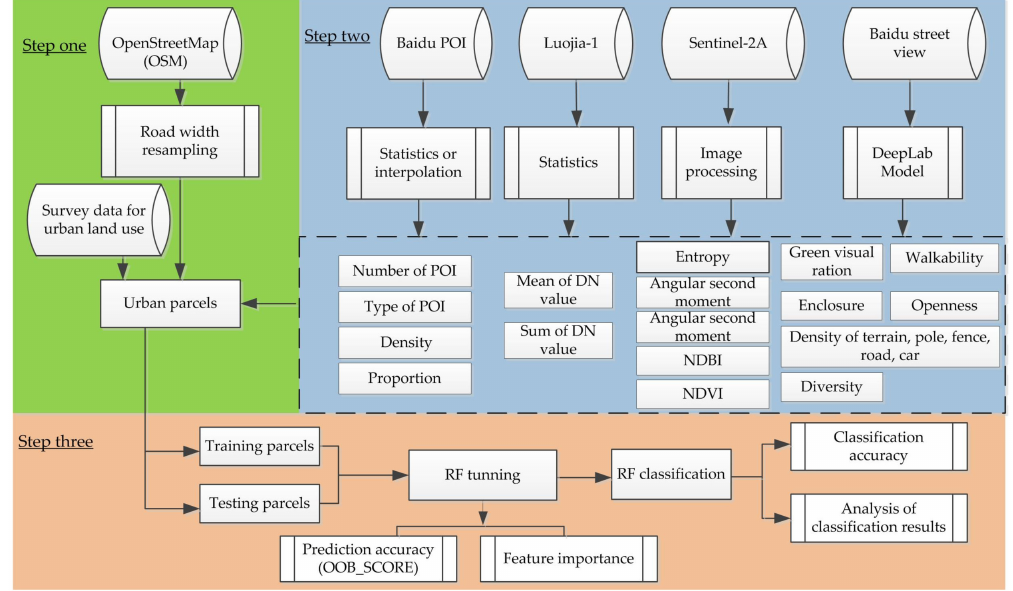
Figure 4. Main flowchart of using street view data and random forest to identify essential urban land use. DN: Digital number; NDBI: Normalized di ff erence built-up index; NDVI: Normalized di ff erence vegetation